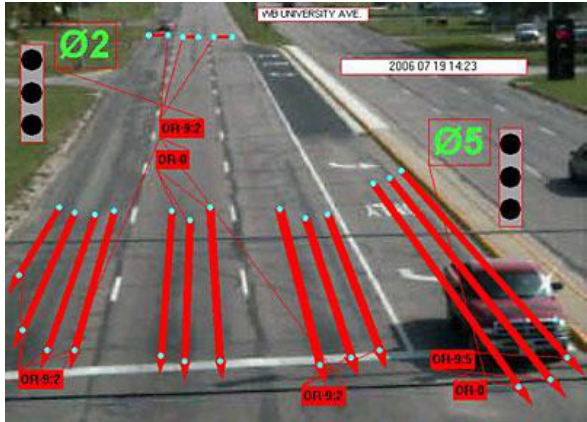
Figure 7. A video image frame